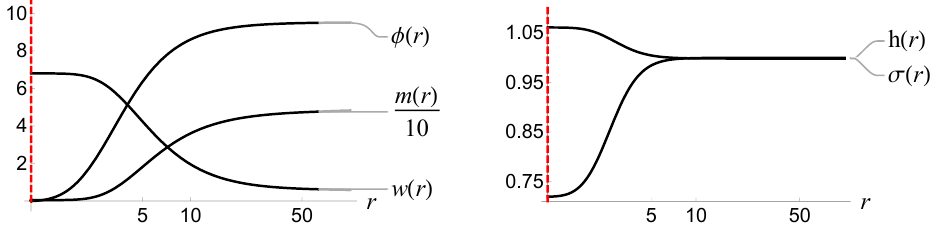
Figure 4 . The exterior solutions corresponding to the parameters (C.17), presented on log plots. The red line represents the horizon. Observe that these are precisely the plots of [24].